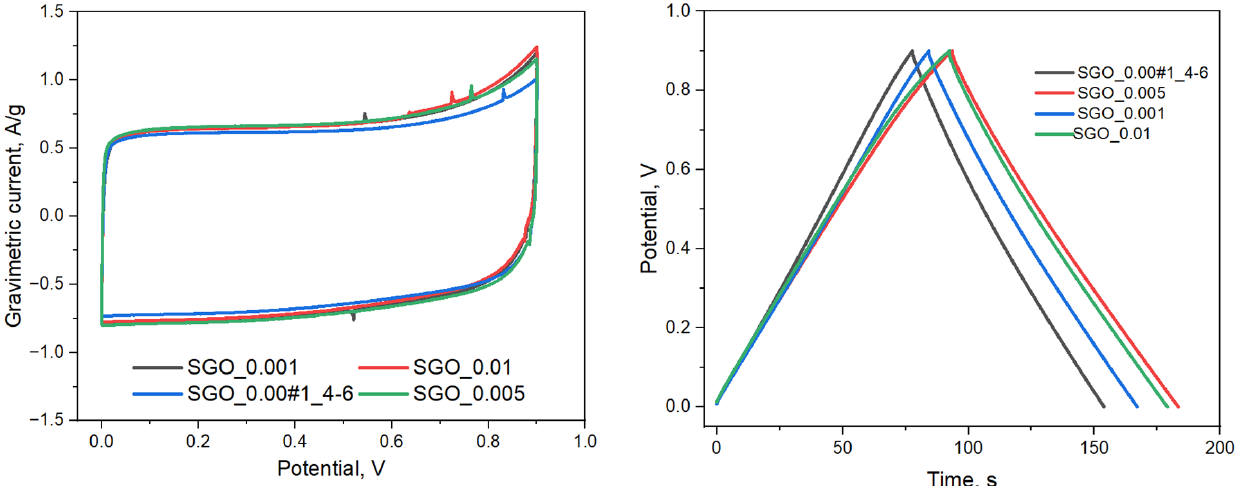
Figure 5. Electrochemical analysis of all samples measured in 6 M KOH; ( a ) Cyclic voltammetry curves at a potential scan rate of 5 mV/s; ( b ) Galvanostatic charge-discharge analysis curves at a current density of 1000 mA/g .